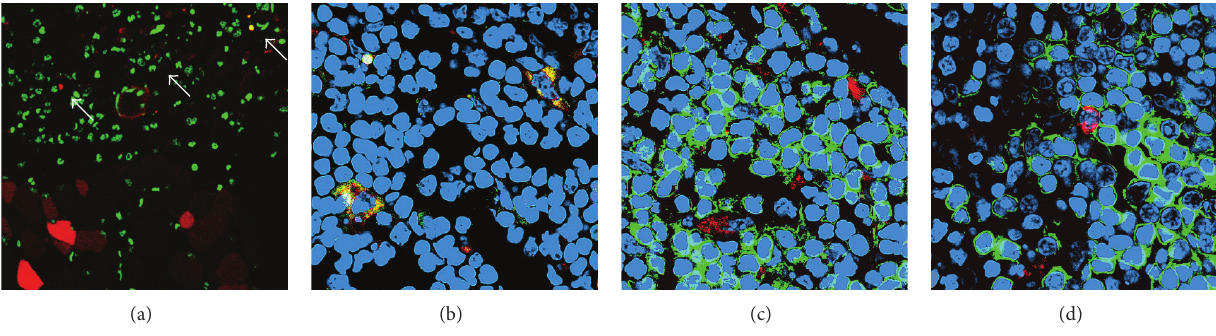
Figure 3: Intradermal EP vaccination transfects dendritic cells that migrate to draining lymph nodes. Transfected (red) muscle fibers and cells (arrows) in skin. Nuclei are shown in green. Magnification × 400. (a) Transfected dendritic cells have migrated into lymph nodes (CD11c in green, EGFP in red). (b) Interaction of dendritic cells that have incorporated EGFP (in red) with CD4 cells (in green) (c). Transfected cells (in red) adjacent to B220 cells (in green) in draining lymph node. (d) Nuclei are shown in blue, magnification × 630. ((b)–(d)) Images are representative of three independent